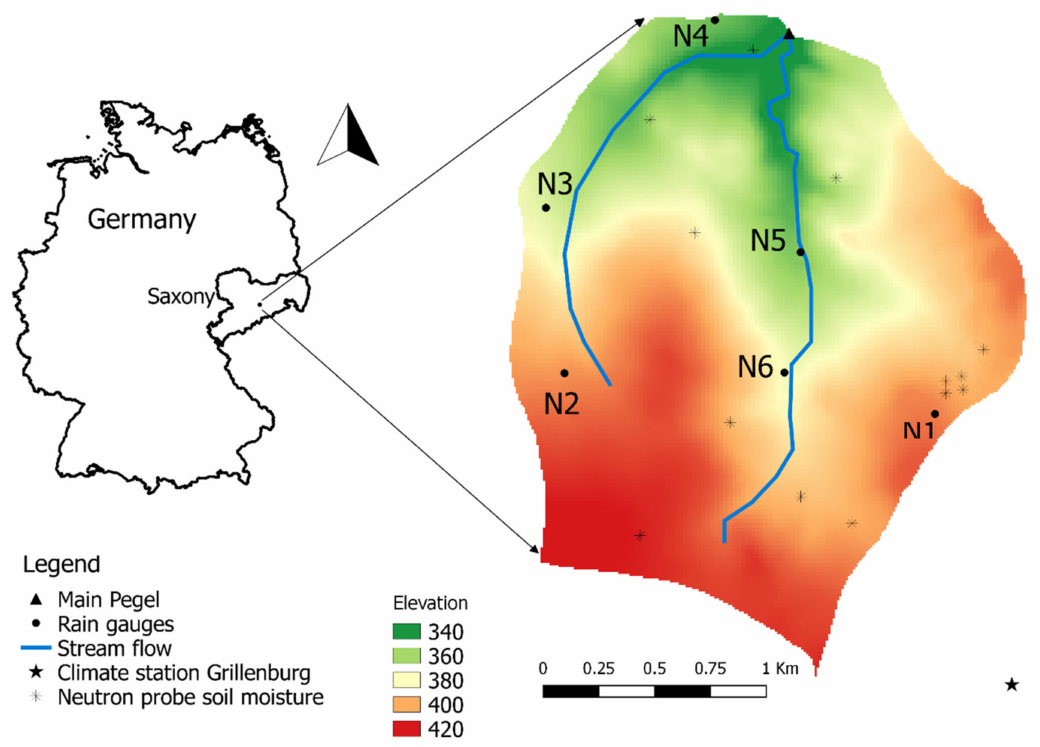
Figure 1. Overview of the study sites in Tharandt Forest, Saxony (Germany). The unit of elevation is